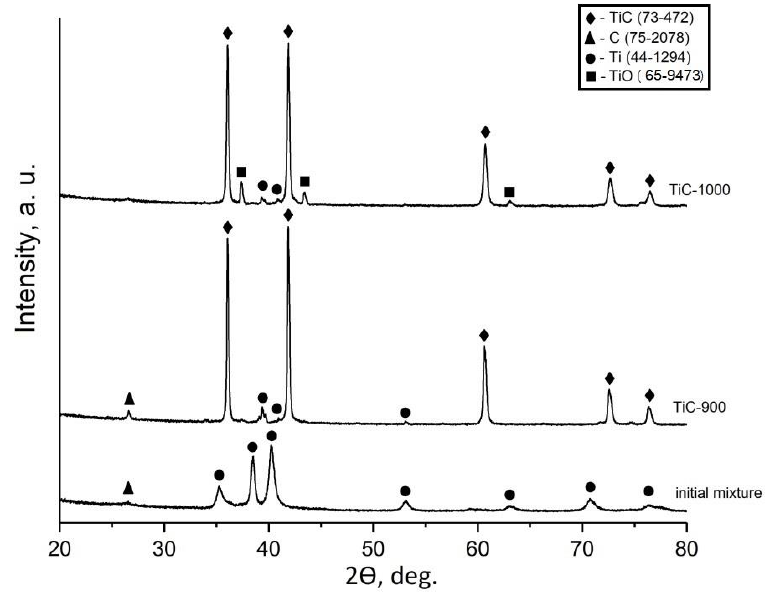
Figure 1. X-ray di ff raction patterns of initial mixture and the obtained samples. Figure 1. X-ray diffraction patterns of initial mixture and the obtained samples.